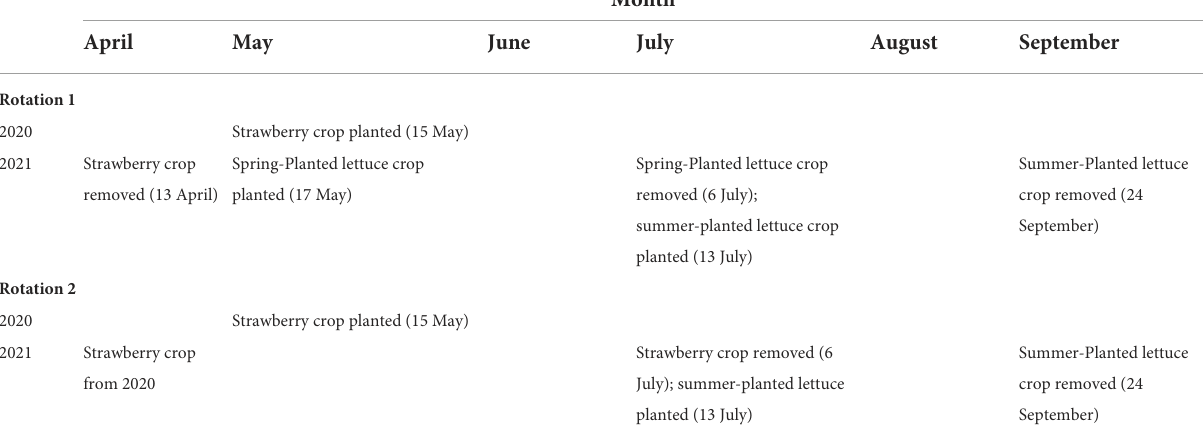
TABLE 1 Rotation scheme for a strawberry–lettuce double-cropping experiment conducted in a Mediterranean climate (northwestern Washington, USA) from April 2020 to September